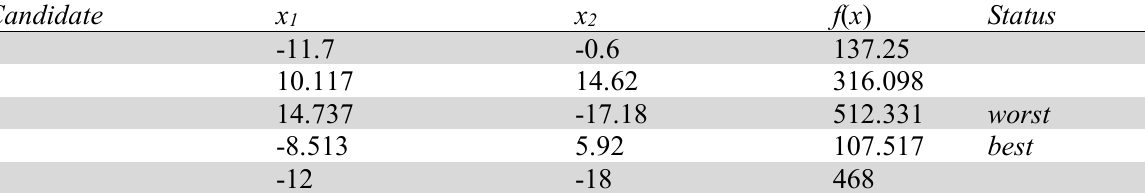
Updated values of the variables and the objective function based on fitness comparison at the end